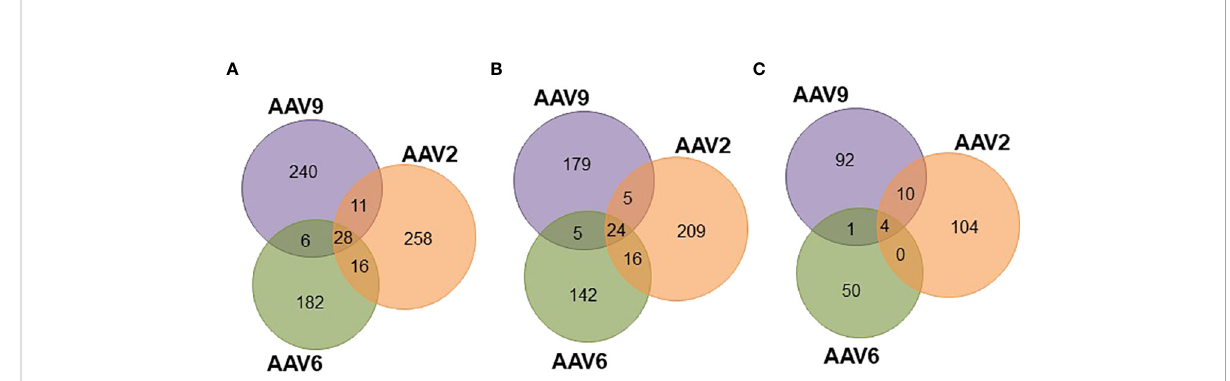
FIGURE 4 Peptides common among serotypes account for differential levels of display prevalence. Venn diagrams representing the overlap of peptides common among serotypes. (A) Total unique peptides identi fi ed in this study. (B) HLA-DR speci fi c peptides. (C) HLA-DQ speci fi c